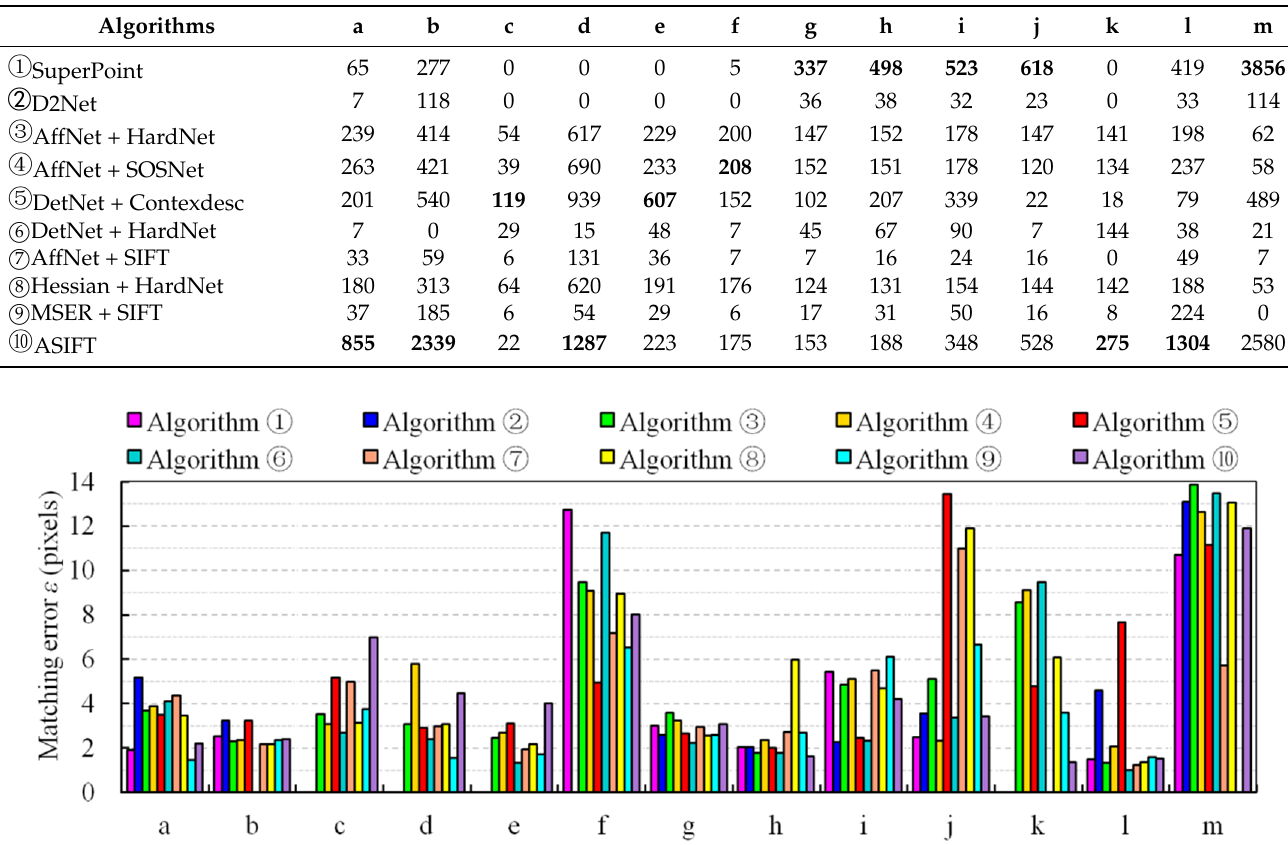
Figure 10. Comparison of the matching error results of the ten algorithms.